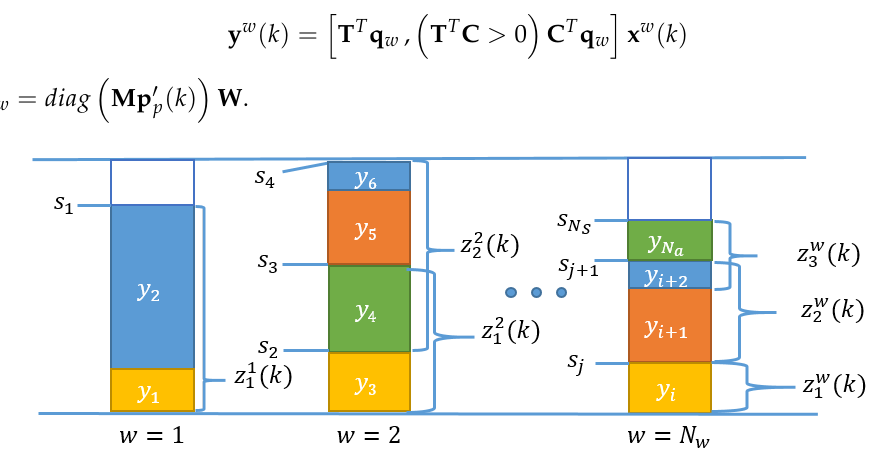
Figure 11. Demonstration of the distribution of the activity times y i , the station times, and the timestamps s j of the fixture sensors; the measured time interval z w ; and the w -th workstation. l The height of the bars coloured illustrates the activity time of the specific activity, while the coloured tag of the individual activities provides information on the type of the specific activity. This representation shows how the related activity times are summed up and form the station time and highlights that the longest station time is the cycle time of the production system, which is represented by the vertical blue line at the top of the